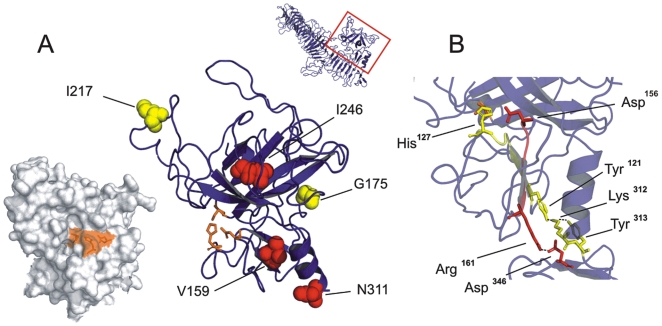
Analysis of proteolytic activity in Domain 1.A. Left: Display of the catalytic triad on the surface of Domain 1. Residues forming the active centre are given as sticks and coloured orange. All residues of the catalytic triad are surface exposed. Right: Insert positions of linker in Domain 1 are marked by coloured spheres indicating the proteolytic activity of the respective constructs. Red spheres symbolise complete loss of activity in the corresponding construct; yellow spheres indicate highly reduced residual activity. Residues forming the catalytic triad are shown as orange sticks. B. Interaction between Domain 1 and the interfacing α-helix. Residues involved in stabilisation of His127 (Tyr121, Lys312 and Tyr313) are shown as yellow sticks, amino acids mediating stabilisation of Asp156 (Arg161 and Asp346) are given in red.